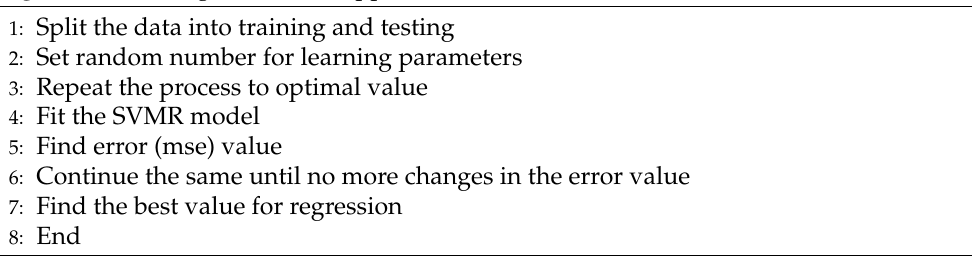
Algorithm 1 An algorithm for support vector